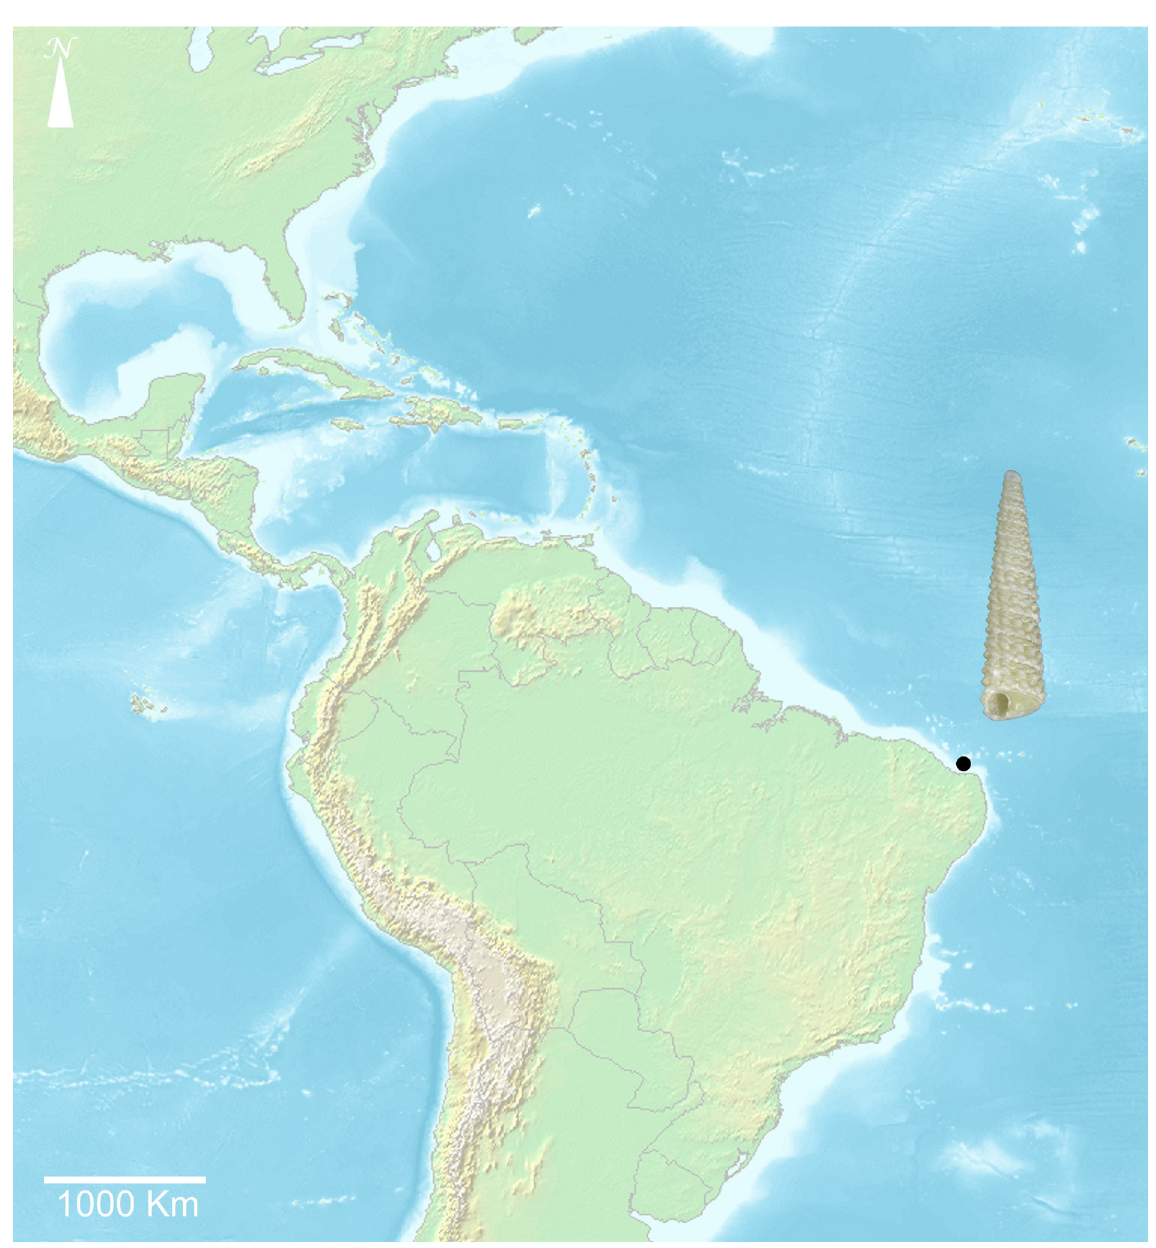
Fig. 75. Distribution map of Strobiligera